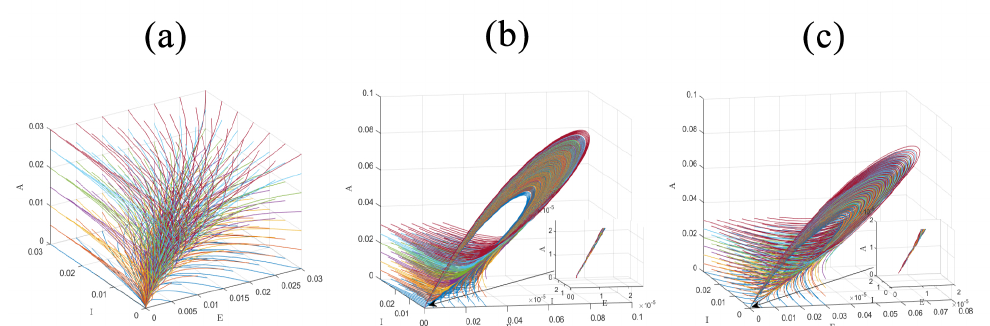
Figure 4. Three-dimensional phase portrait of ( E , I , A ) trends. ( a ) All ( E , I , A ) lines starting from different initial conditions approach to the origin with R t = 0.3824 (stage 2) which illustrate the vanish of COVID-19. ( b ) The ( E , I , A ) lines reach a non-zero point which demonstrate the endemic equilibrium with R 0 = 2.1014 (stage 1). ( c ) The ( E , I , A ) lines reach another non-zero point which demonstrate endemic equilibrium with R t = 1.8004 (stage 3).